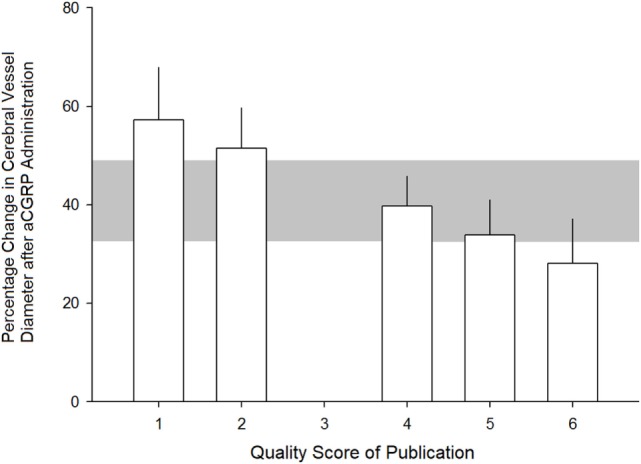
Relationship between quality score of studies and estimated efficacy of alpha calcitonin gene-related peptide at dilating cerebral arteries. See Section “Methods” for quality scoring criteria. Error bars represent SE while the gray area represents the grouped (all studies) estimate. Differences were not statistically significant (p > 0.05).